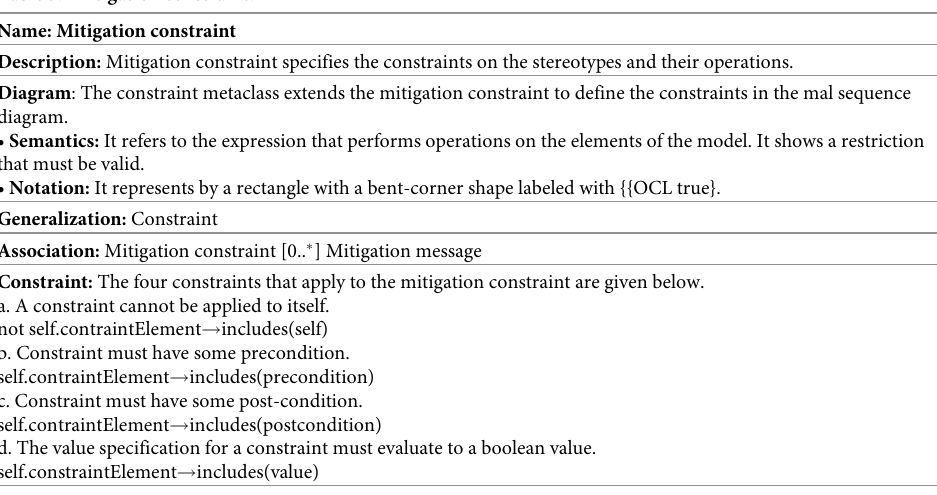
Table 3. Mitigation constraint.